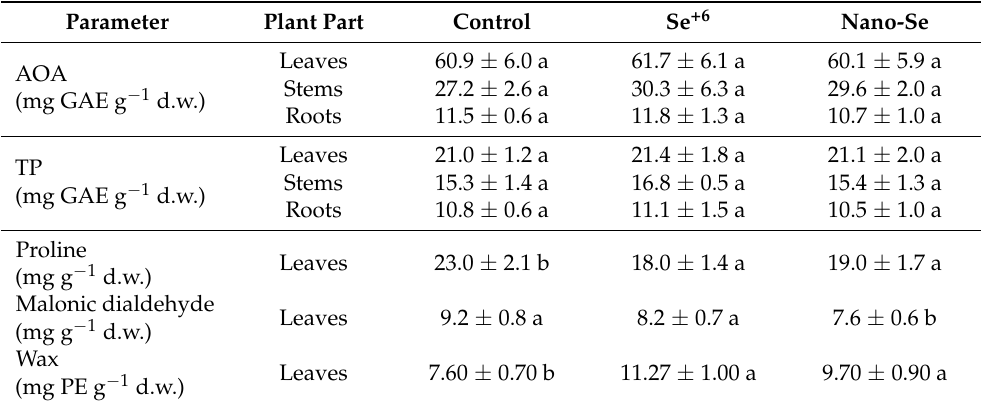
Table 3. Total antioxidant activity (AOA) and polyphenol (TP), proline, malonic dialdehyde (MDA) and lipid content in control and Se biofortified A. annua